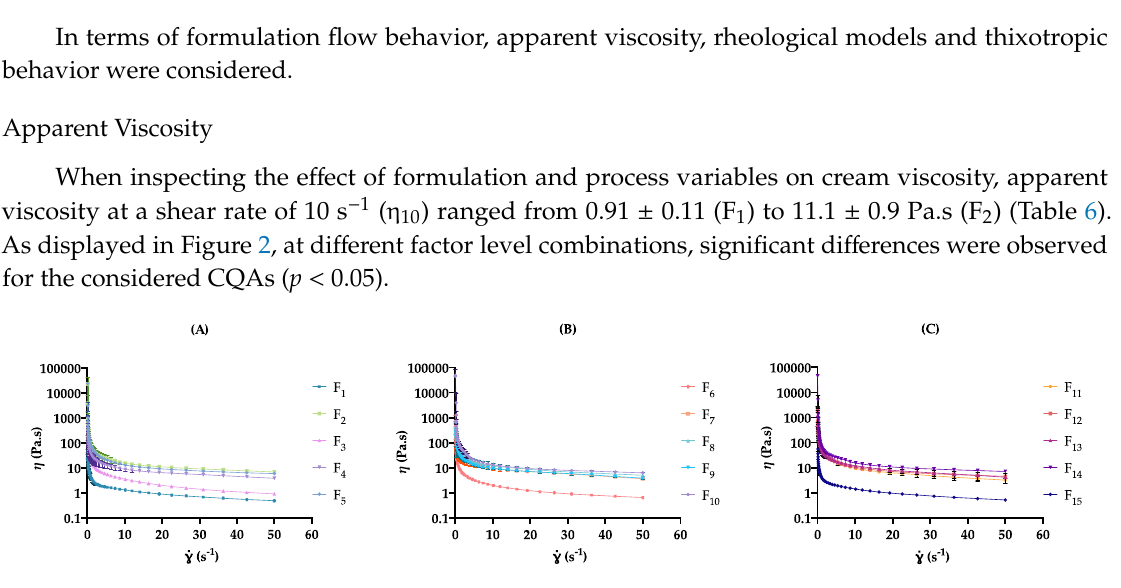
1 –F 5 , ( B ), F 6 –F 10 and ( C ) F 11 –F 15